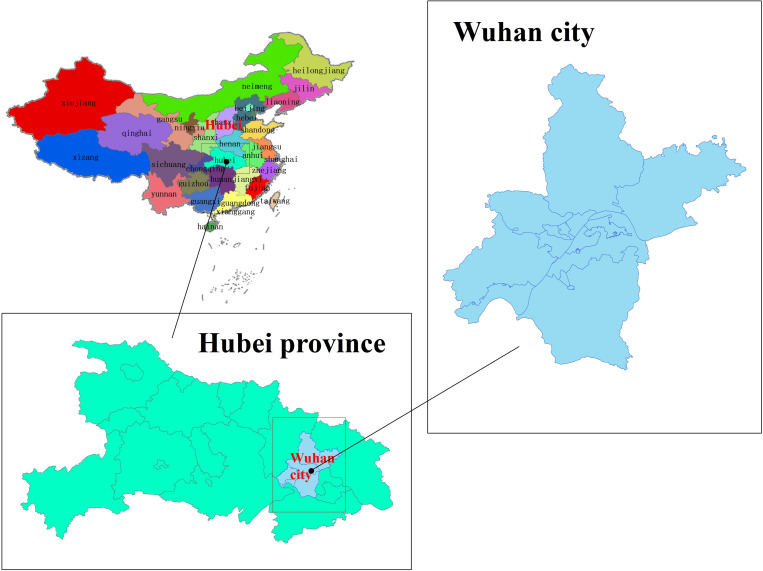
Study population.